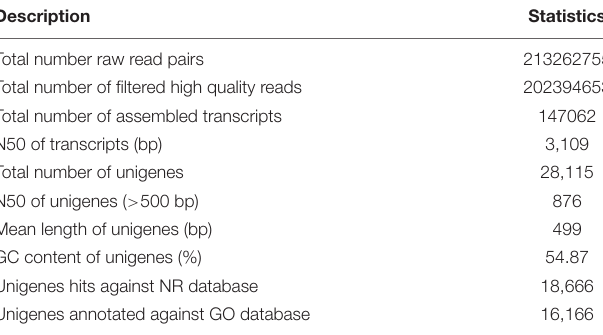
TABLE 1 | Transcriptome assembly and annotation